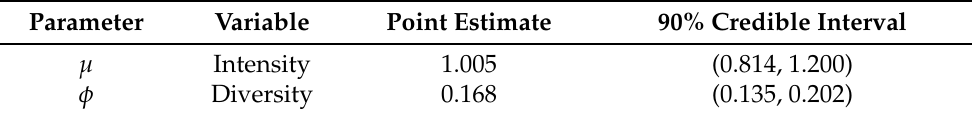
Figure 16. Posterior distributions and trace plots for the field detection count distribution model. Well mixing and convergence are achieved. Table 1. Parameter estimates of field detection count